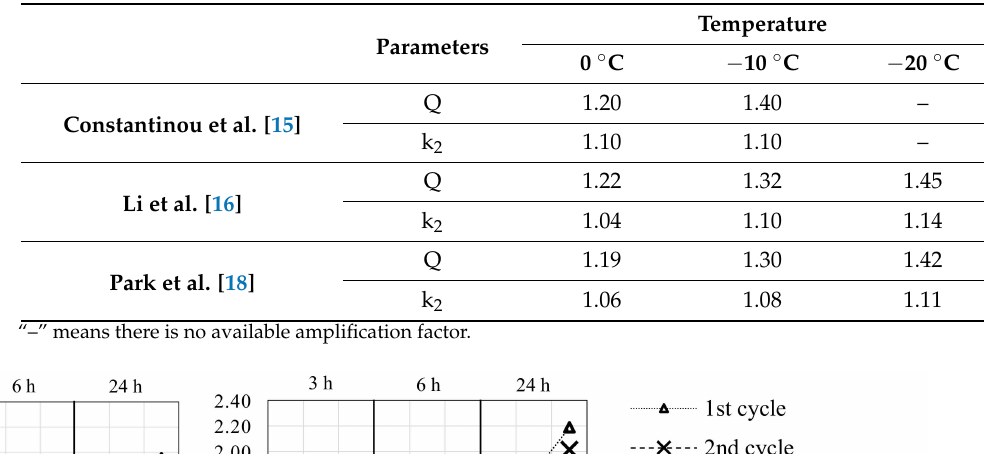
Table 4. Amplification factors suggested for different temperatures.